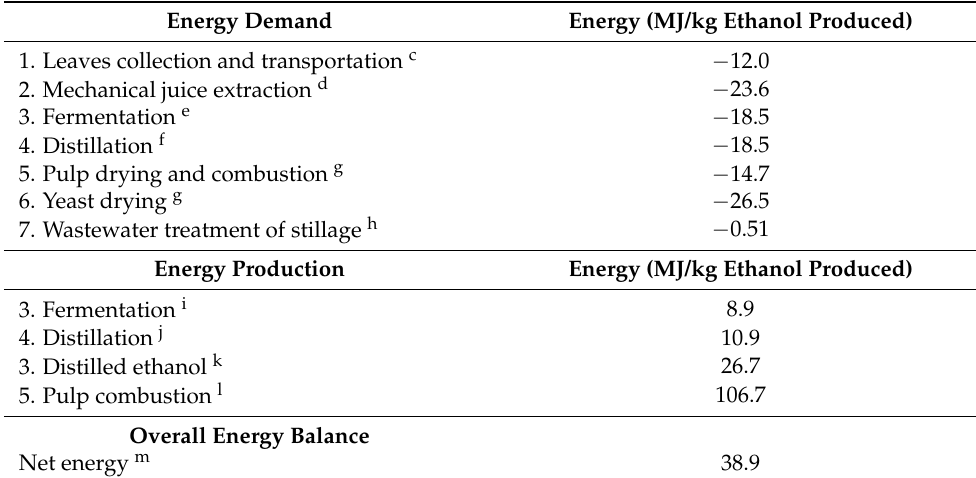
Table 2. Energy balance of a regional pineapple leaf biorefinery a, b.